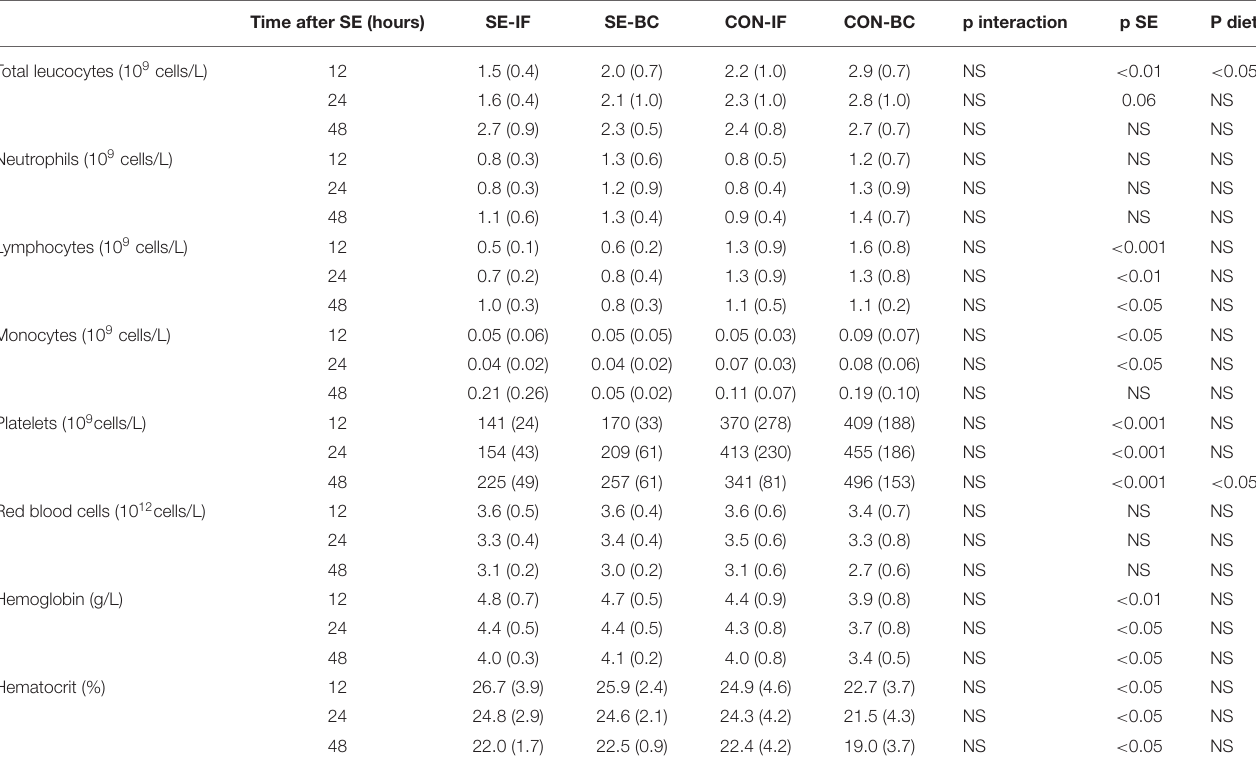
TABLE 4 | Hematological parameters in Experiment 3 . Time after SE (hours) SE-IF SE-BC CON-IF CON-BC p interaction p SE P